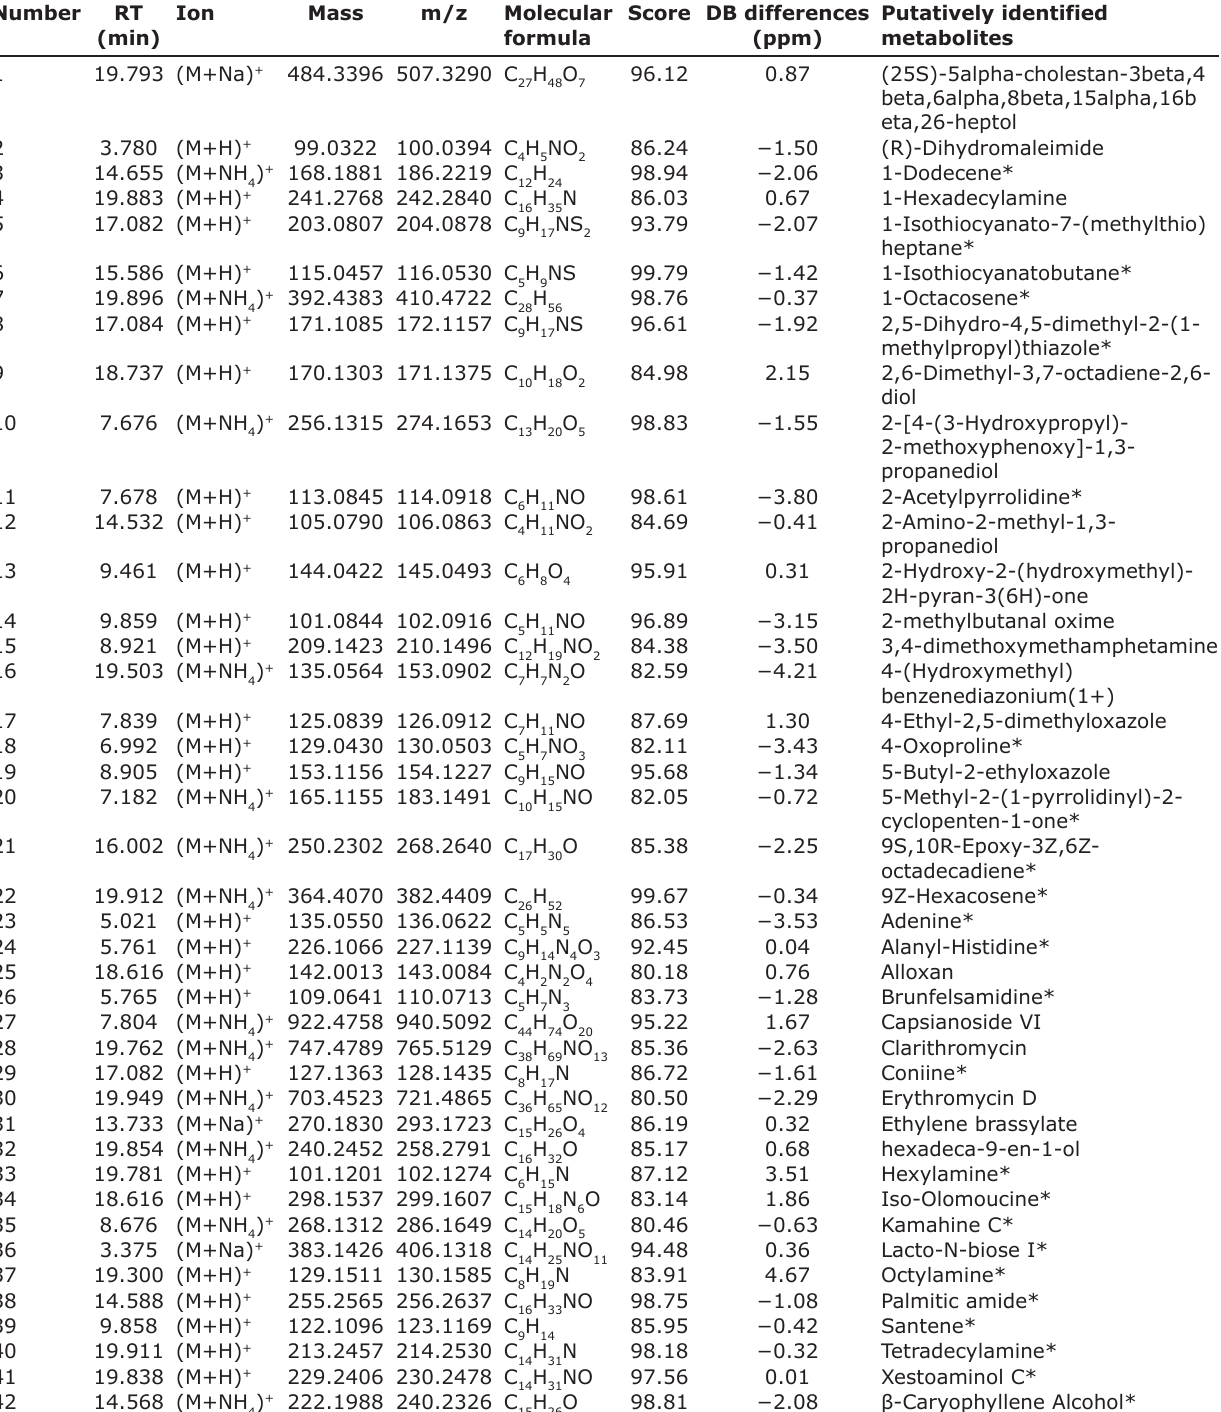
Table-4: Information of the metabolites in pHMG extract. The metabolites are identified by QTOF LC-MS with second screening evaluation.